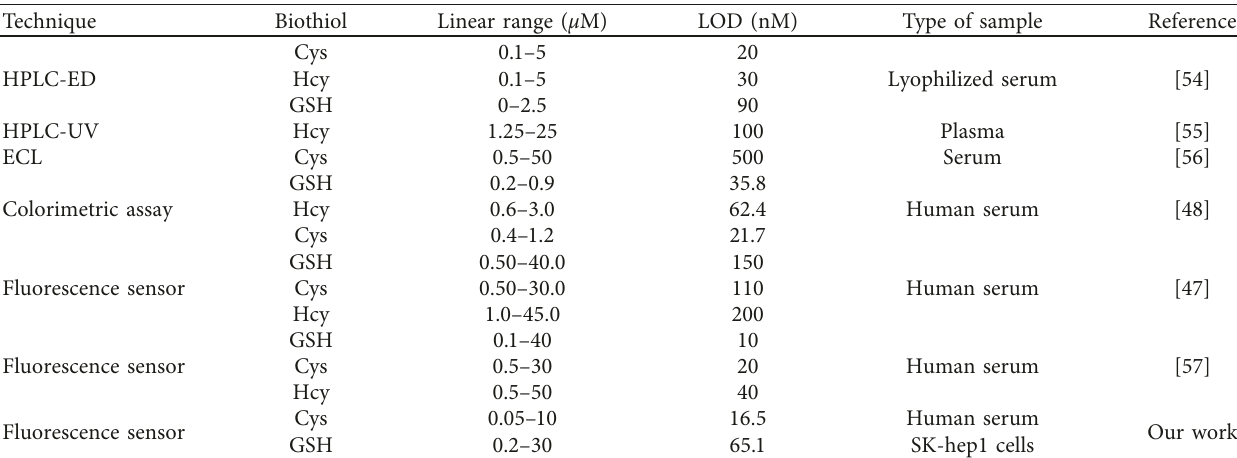
Table 2: A comparison of the analytical characteristics of different methods for the detection of biothiols. Technique